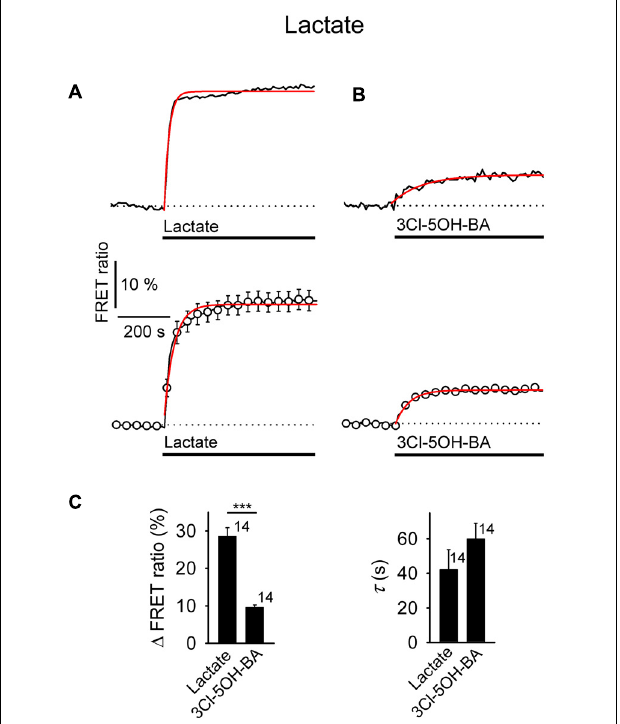
FIGURE 5 | Comparison of increases in [lactate] i by extracellular L -lactate and 3Cl-5OH-BA in astrocytes. (A,B) Representative (above) and mean time-course (below) of the Laconic FRET ratio signal upon the addition of (A) L -lactate (20 mM) and (B) 3Cl-5OH-BA (0.5 mM). Data are expressed as the percentages of FRET ratio signals (mTFP/Venus) relative to the baseline ratio values. Single exponential rise functions were fitted to the curves: ( A , above) FRET ratio = [0.81 ± 0.02] + [0.44 ± 0.02] × (1 – exp (– t /[18.80 ± 1.10 s])), ( A , below) FRET ratio = [1.02 ± 0.01] + [0.24 ± 0.01] × (1 – exp(– t / [39.06 ± 2.44 s])), and ( B , above) FRET ratio = [1.00 ± 0.00] + [0.06 ± 0.00] × (1 – exp(– t /[116.28 ± 14.87 s])), ( B , below) FRET ratio = [0.98 ± 0.00] + [0.09 ± 0.00] × (1 – exp(– t /[54.05 ± 2.34 s])). Note that the addition of L -lactate and 3Cl-5OH-BA increased the FRET ratios, indicating an increase in [lactate] i . Each data point represents the mean ± s.e.m. (C) Mean changes in the FRET ratio ( (cid:49) FRET ratio; left) and mean time-constants ( τ ; right) upon L -lactate and 3Cl-5OH-BA stimulation. Numbers by the error bars depict the number of cells analyzed. Data shown are in the format of the mean ± s.e.m ( ∗∗∗ P < 0.001). Data for every set of experiment was acquired from at least two different